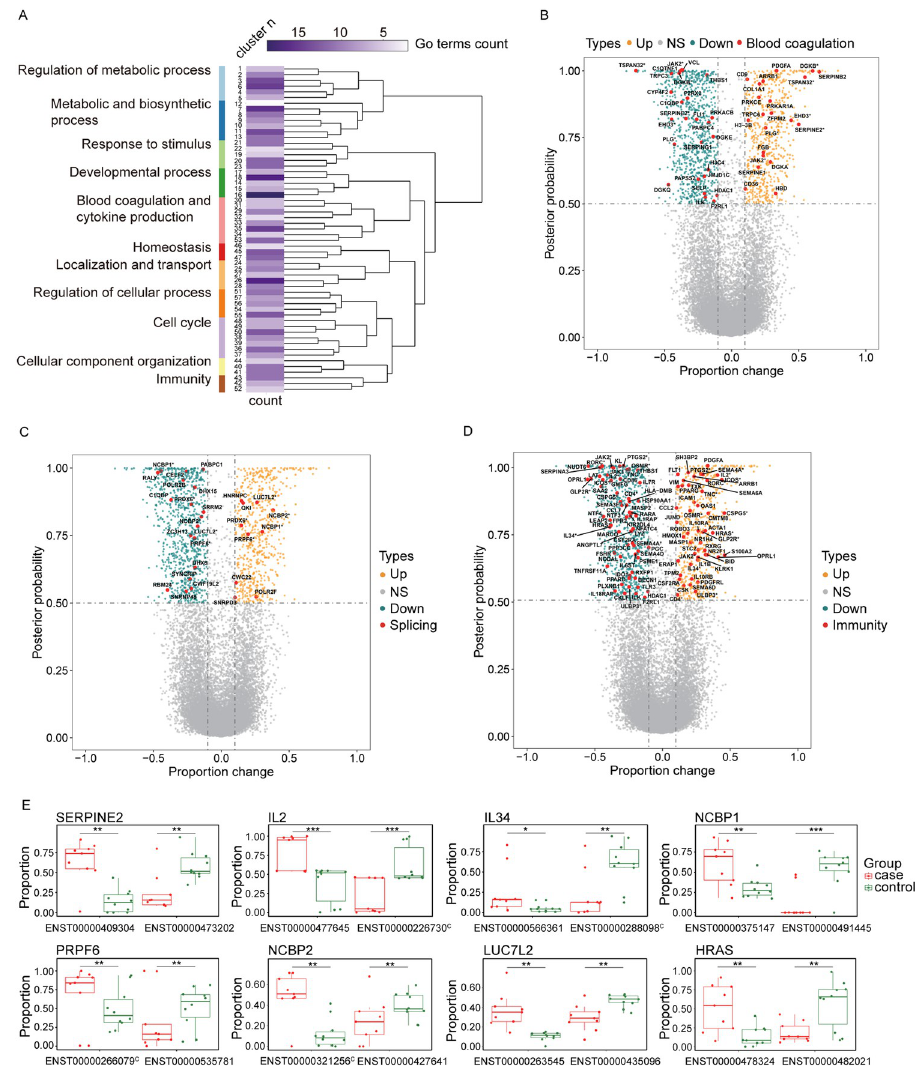
Fig 3. Transcriptional profiling reveals widespread dysfunction of cellular gene expression in the lungs of fatal COVID-19 patients. (A) Functional analysis of 1383 genes with significant DTU. The clustering heatmap plot of functional sets of GO terms was obtained using ViSEAGO showing the major biological processes, cluster number and number of GO terms in each cluster. Based on BMA semantic similarity distance and Ward’s clustering criterion. (B-D) A volcano plot (posterior probability vs. proportion change) comparing gene transcript usage in cases versus controls is shown at mRNA level. DTUs that were related to blood coagulation (B), RNA splicing (C) and immunity (D) are named. The horizontal dashed line represents posterior probability of 0.5, and the vertical dashed lines represent proportion change of -0.1 and 0.1. � represents isoform switch. (E) Isoform switch of SERPINE2 , IL2 , IL34 , NCBP1 , PRPF6 , NCBP2 , LUC7L2 and HRAS . C represents canonical isoform. � posterior probability > 0.5; �� posterior probability > 0.7; ��� posterior probability >